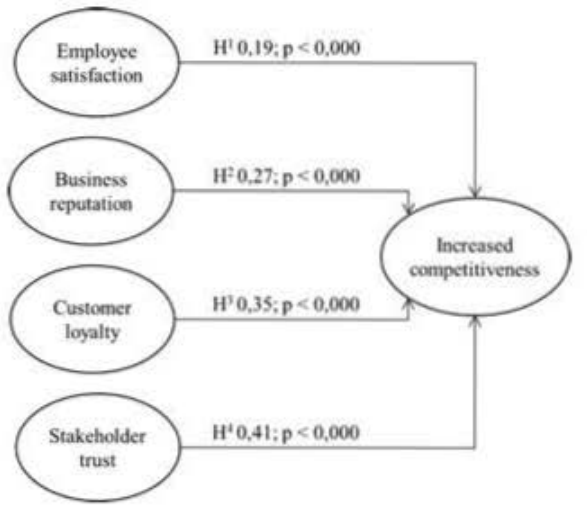
Figure 2: :Empirical firtdings of factors determining the Jnereased eo mpetitiVti'leSS of